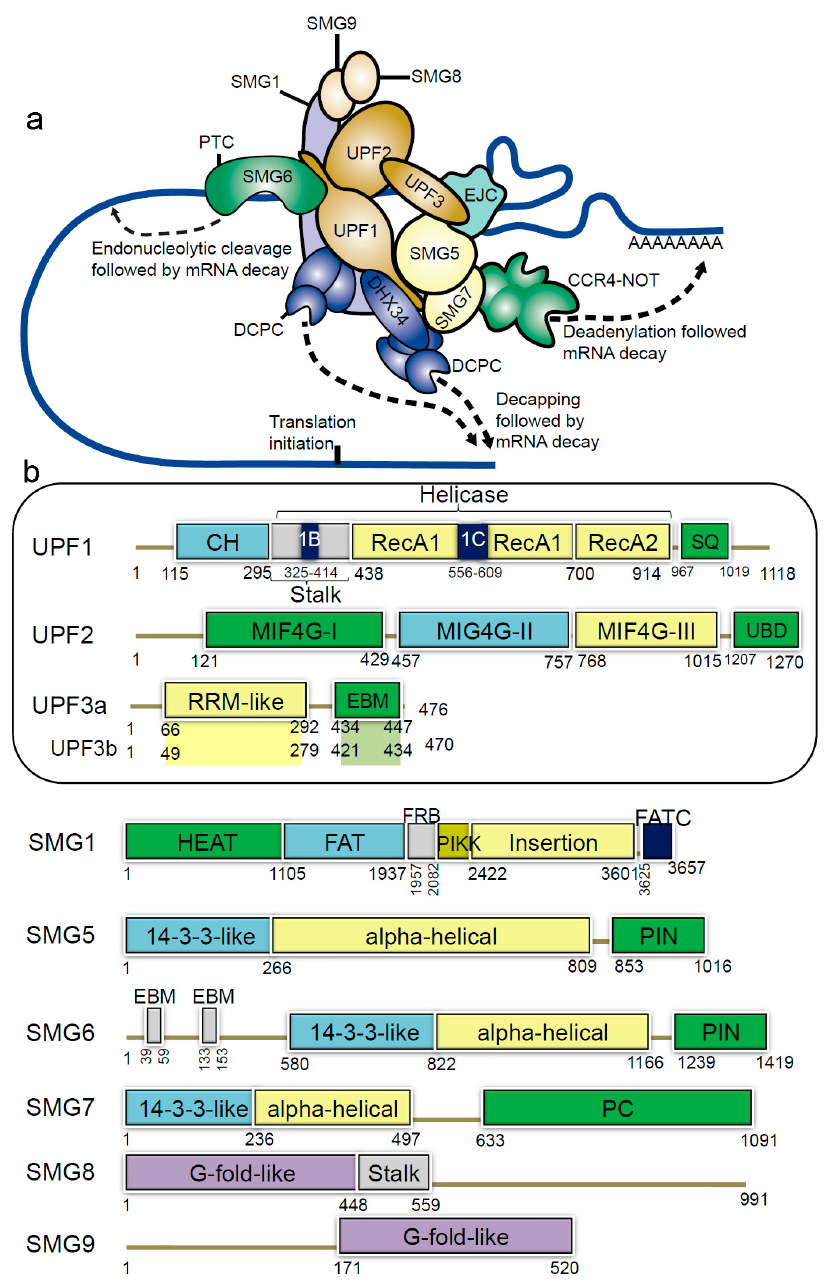
Figure 1. Schematic representation of domains and motifs of the nonsense-mediated mRNA decay (NMD) factors. (a) The NMD complex UPF: up-frameshift; SMG: suppressor of morphogenetic effect on genitalia; DHX34: DEAH box polypeptide 34; DCPC: the decapping complex; EJC: exon junction complex; CCR4-NOT: carbon catabolite repressor protein 4 (CCR4)–NOT deadenylase complex [31]. (b) For the UPF and SMG proteins: CH: cysteine-histidine rich domain; Stalk: RecA1 domain by two long ‘stalk’ helices; RecA1 and RecA2: RecA-like domains; 1B and 1C: subdomains within the helicase core; SQ: serine-glutamine rich domain; RRM: RNA recognition motif; EBM: exon junction binding motif; MIF4G: middle of 4G-like domains; UBD: UPF1-binding domain; PIN: PilT N-terminus